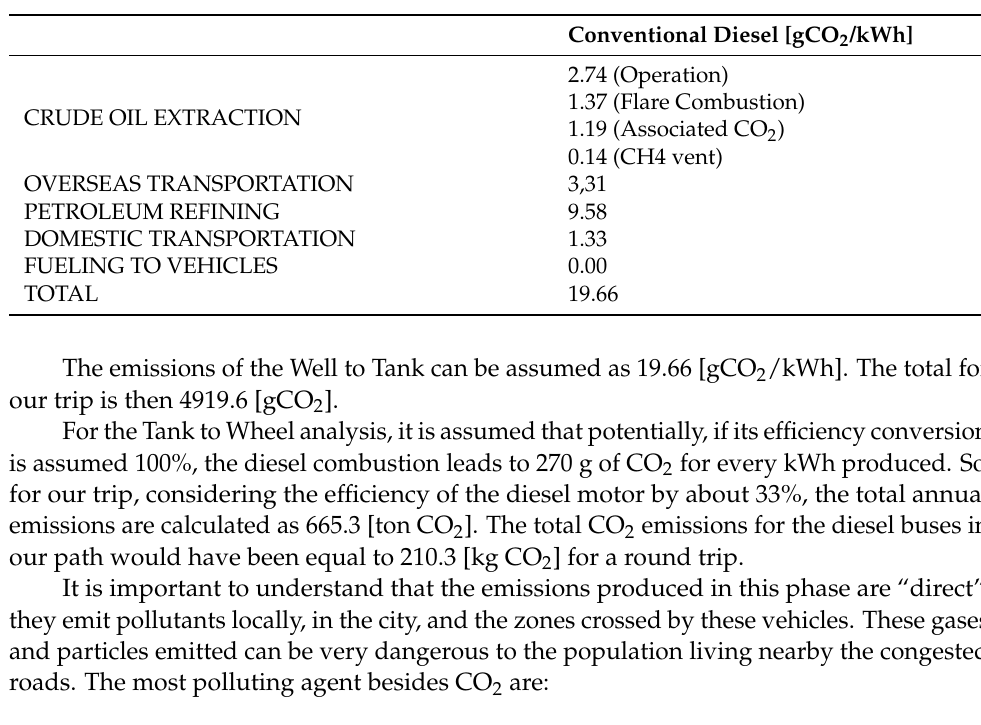
Table 5. Emissions related to Diesel Cycle